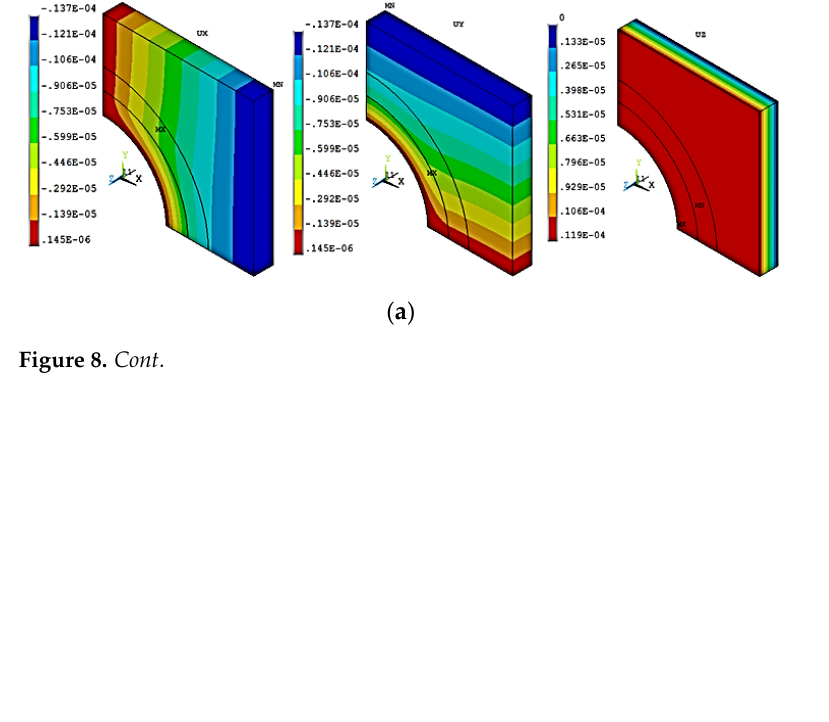
Figure 7. Poisson’s ratio for different Hierarchical Models.